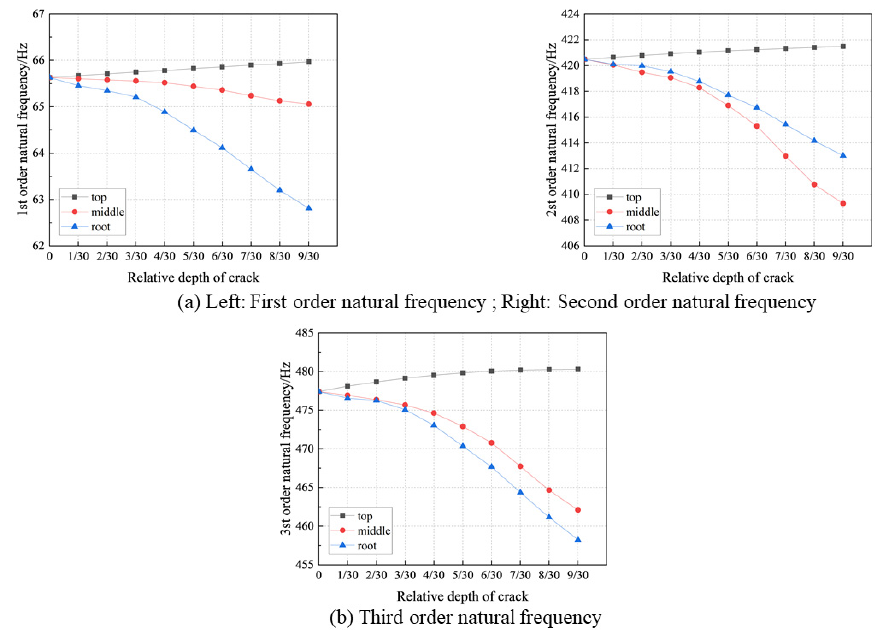
Figure 13. The first three orders of natural frequency of the blade at different crack depths.